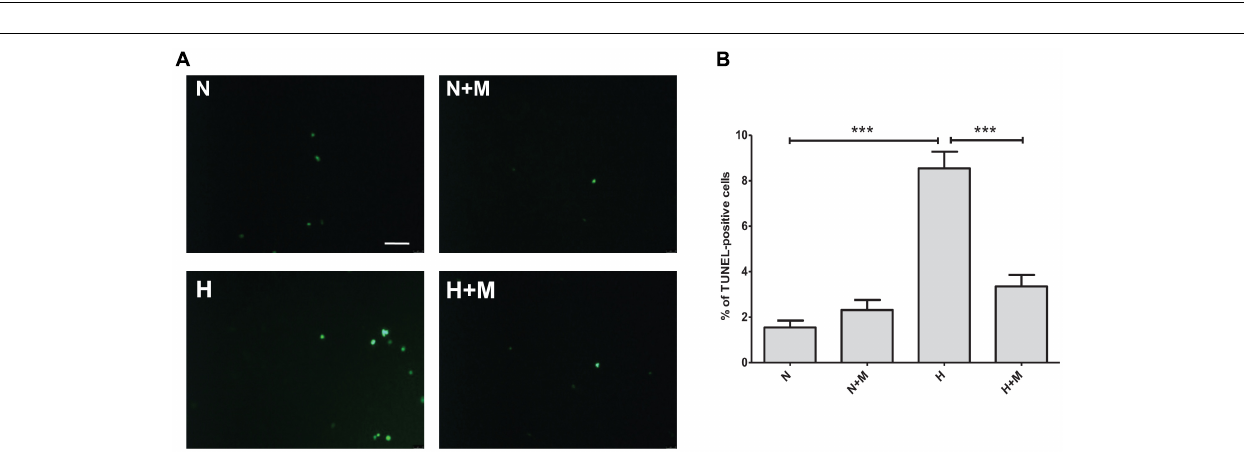
FIGURE 4 | Metformin protects against hypoxia-induced apoptosis in H9C2 cells. (A) TUNEL staining of apoptotic cells subjected to normoxia (N) or hypoxia (H) in the presence or absence of 5 mM metformin (M). (B) Quantification of TUNEL-positive cells from (A) . Scale bar is 100 µ m. Data represents the mean ± SEM from at least three independent experiments. Statistical analysis was carried out by one-way ANOVA: ∗∗∗ P < 0.001 between indicated conditions.